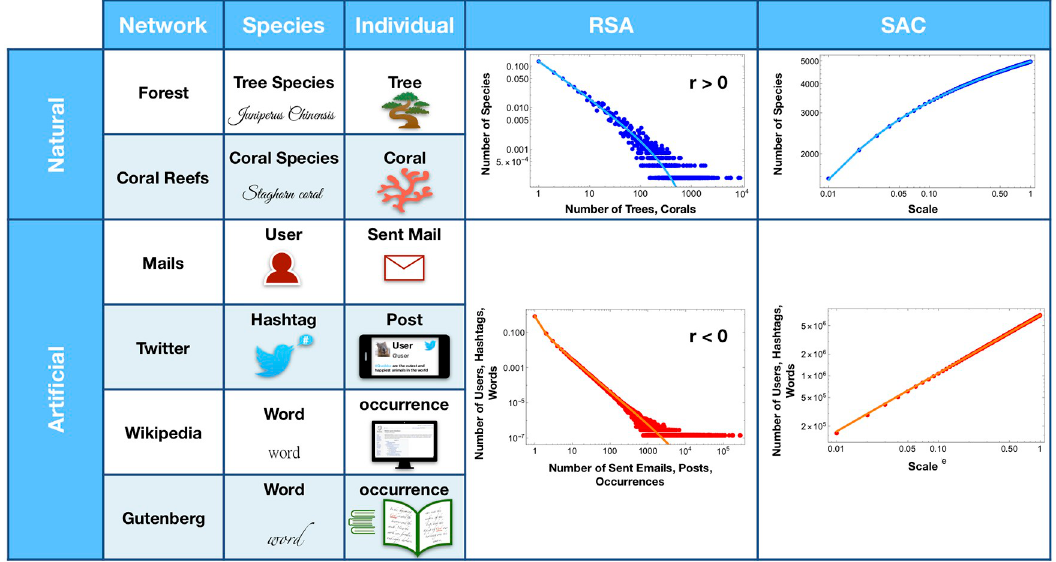
Fig 1. From ecology to human activities. The figure depicts the correspondence between species/individuals in a natural ecosystem and users/sent emails, hashtags/posts, words/occurrences in each one of the four datasets considered in the paper. Once the proper correspondence is established, it turns out that both natural and artificial RSAs can be well described by a negative binomial distribution. In the latest two columns, in order to show the typical shapes of the RSA (i.e. Relative Species Abundance) and SAC (i.e. Species Accumulation Curve) curves for natural versus human activity systems, we display the empirical patterns obtained for the Amazonia rainforest [8] and Twitter dataset. In general, all human activity RSA curves can be accommodated by with a negative value of clustering coefficient r in the interval ( − 1, 0) (see Eq 1), whereas natural ecosystems prefer r > 0 (solid